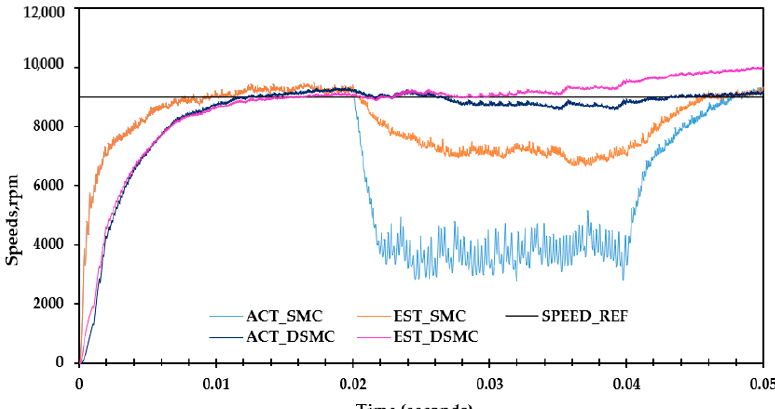
Figure 26. Increments of the moment of inertia by 10%. [Note: ACT_SMC: actual speed under sliding mode controller; EST_SMC: estimated speed under sliding mode controller; ACT_DSMC: actual speed under dynamic sliding mode controller; EST_DSMC: estimated speed under dynamic sliding mode controller; SPEED_REF: reference speed].